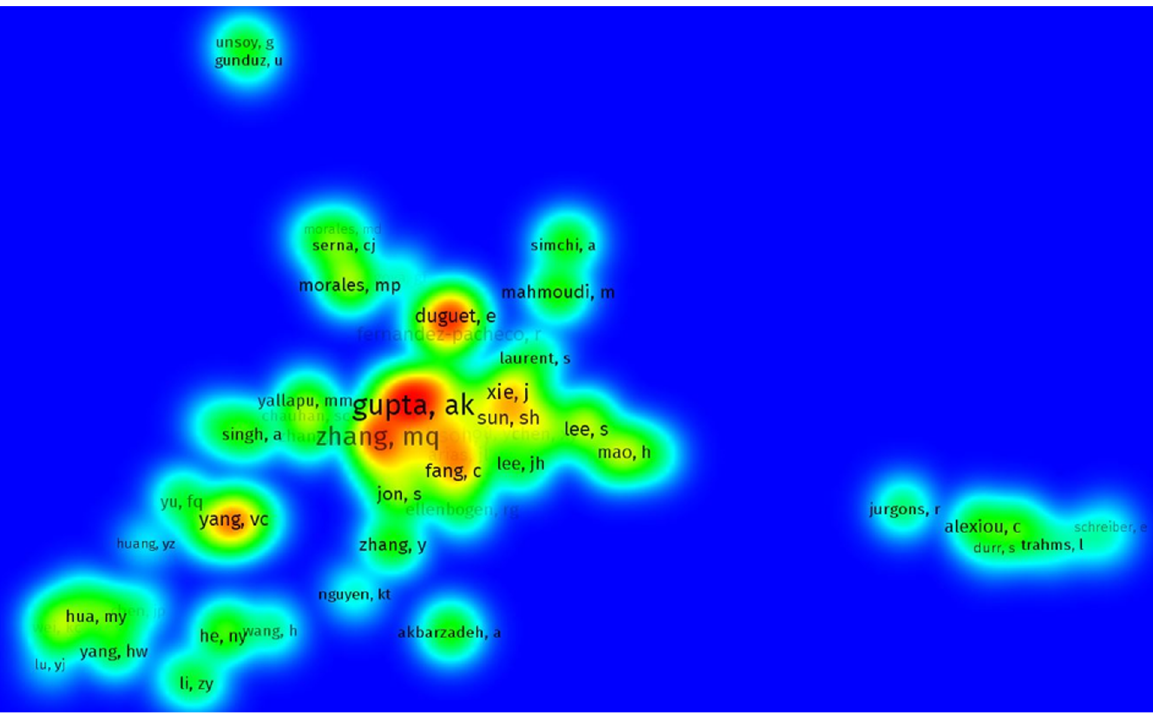
Fig. 3 Important authors with the number of article citations